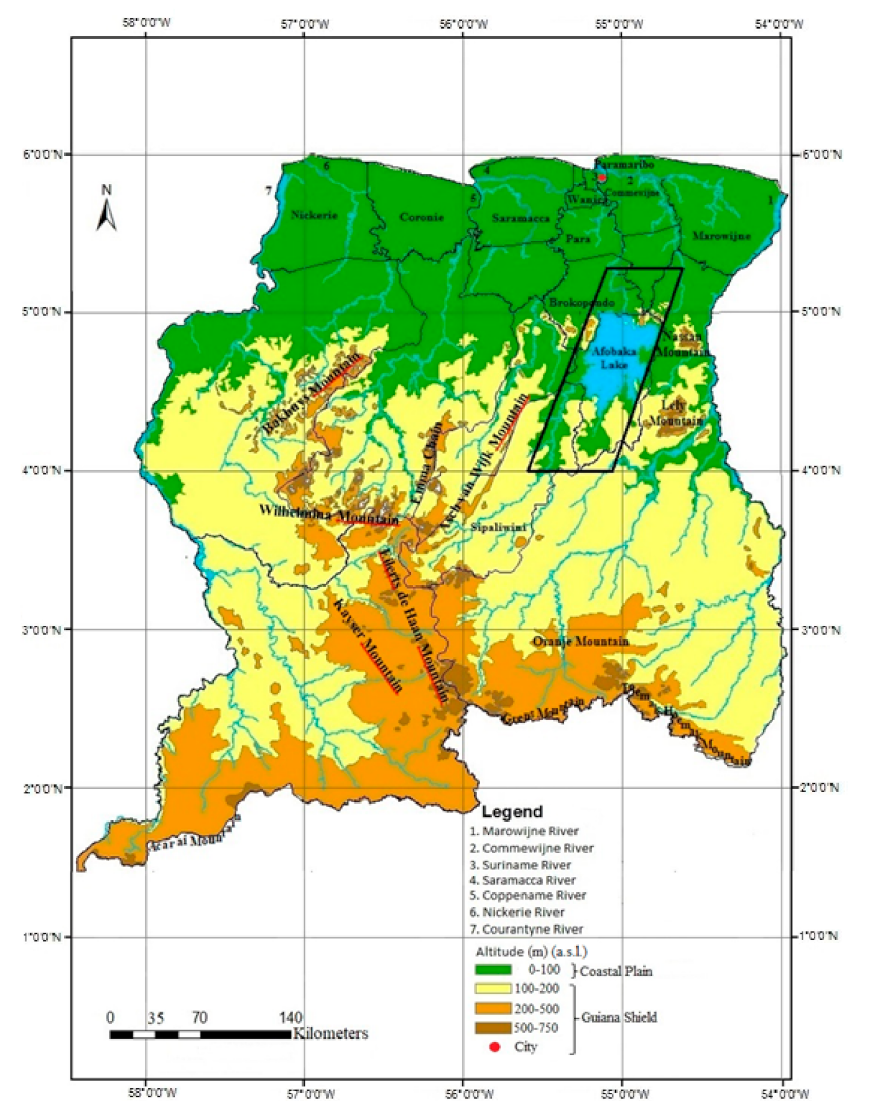
Figure 1. Simplified topographic map and hydrographic network of Suriname with its seven main rivers (Marowijne, Commewijne, Suriname, Saramacca, Coppename, Nickerie, and Courantyne Rivers) in the north. The frame indicates the location of the study